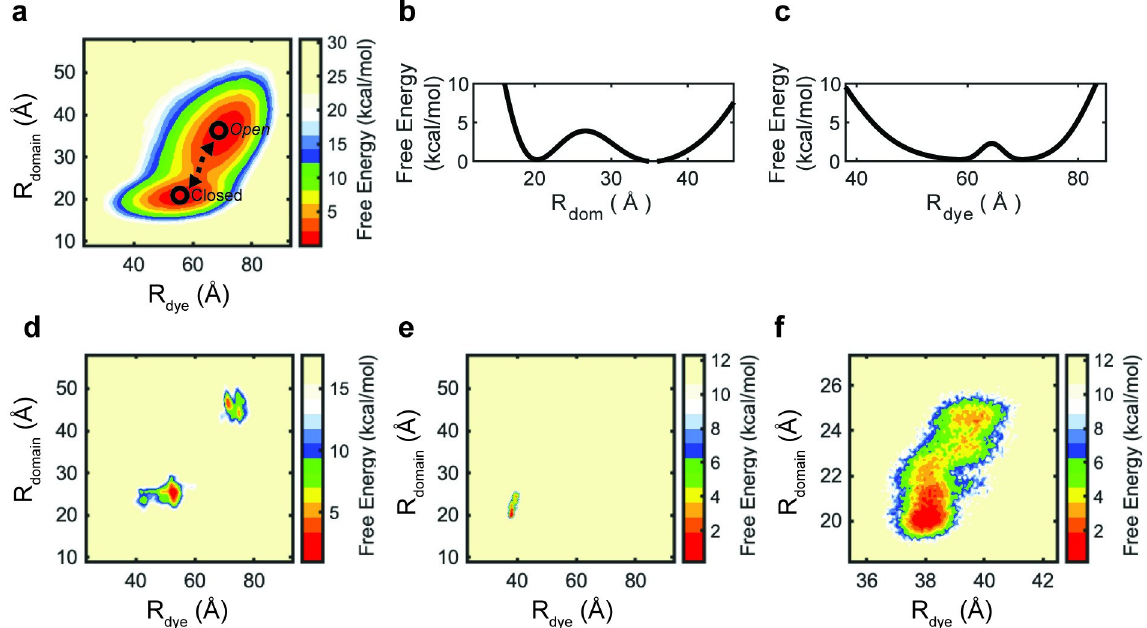
Fig 4. Correlation of the fluorophore and inter-domain distances of LIV-BP SS . (a) Boltzmann-weighted free energy landscape with reaction coordinates of inter-domain distance (R domain ; left axis) and inter-dye distance (R dye ; bottom axis) from 100 x 500 million-time steps structure- based simulations (50 billion-time steps). The vertical axis (scale bar at right) represents the fraction of simulation time, calculated as a relative free energy (see Methods). The centers of the energy basins refer to the apo and Leu-bound structures, highlighted with black circles. The Pearson correlation coefficient for the two reaction coordinates is 0.73 indicating a correlation between the estimated distances between the LIV-BP SS domains and conjugated fluorophores. The barrier between the Leu-bound and apo states (black circles) is ~ 2–4 kcal/mol. (b) Free energy along the reaction coordinate R domain . (c) Free energy along the reaction coordinate R dye. (d-e) R domain with respect to R dye for explicit solvent simulations of LIV-BP SS in the (d) apo and (e) Leu-bound states. Free energy landscapes of explicit solvent simulations are from three, 1 μ s simulations, as such the separate peaks of the apo states are from different trajectories. (f) A zoom in on the Leu-bound free-energy landscape (panel e).